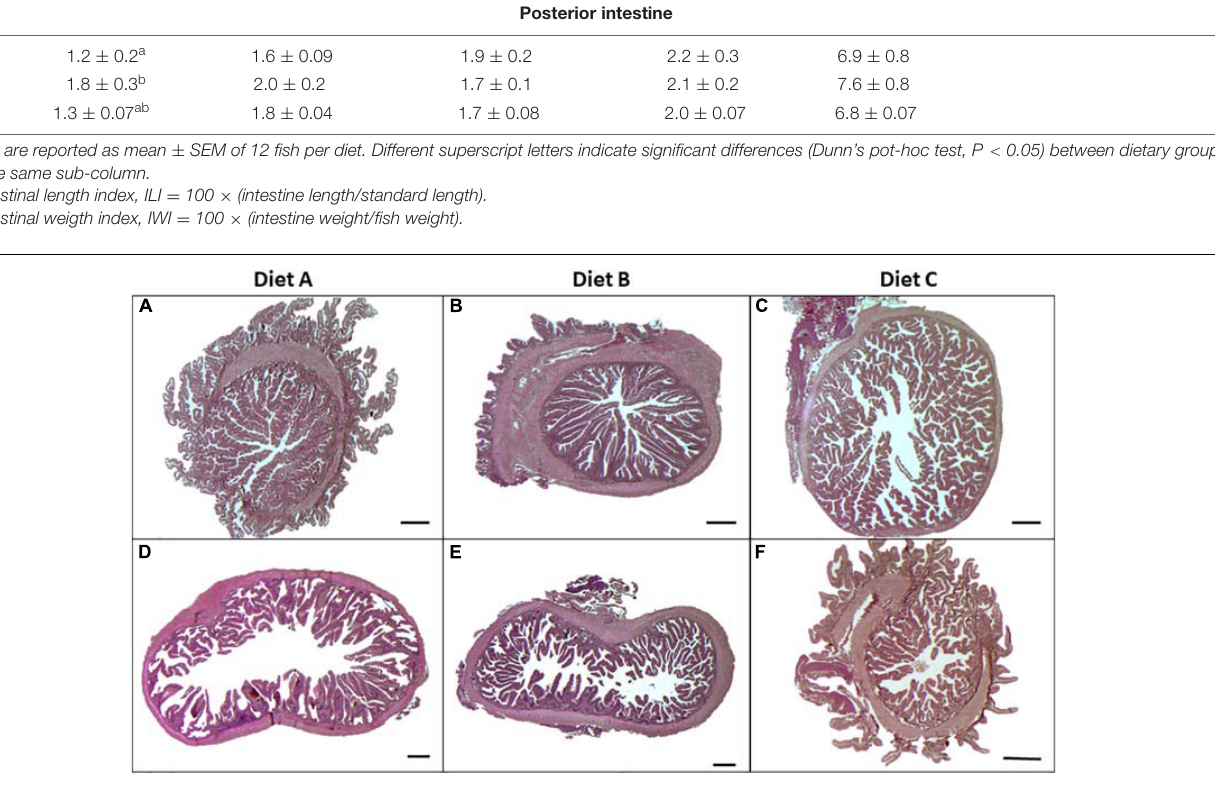
FIGURE 1 | Light microscope images obtained from anterior (A–C) and posterior (D–F) intestine of gilthead sea bream juveniles ( Sparus aurata ) fed with diets A, B, and C, stained with hematoxylin and eosin (H&E). Scale bar = 500 µ